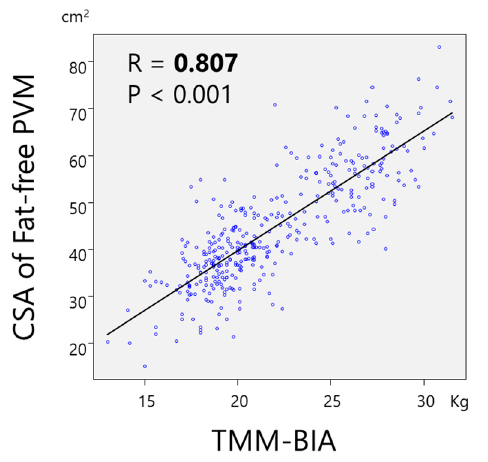
Figure 2. Correlation between TMM–BIA and the CSA of PVM. There was a significant correlation between TMM–BIA and the CSA of PVM with r = 0.746. TMM–BIA, trunk muscle mass measured by bioelectrical impedance analysis; CSA, cross-sectional area; PVM, paravertebral muscles.